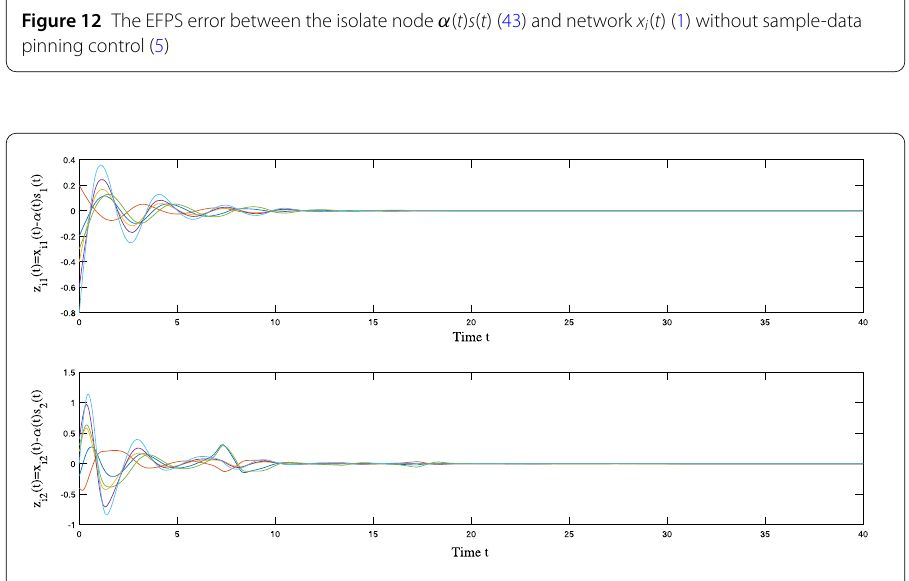
Figure 13 The EFPS error between the isolate node α ( t ) s ( t ) (43) and network x i ( t ) (1) with sample-data pinning control